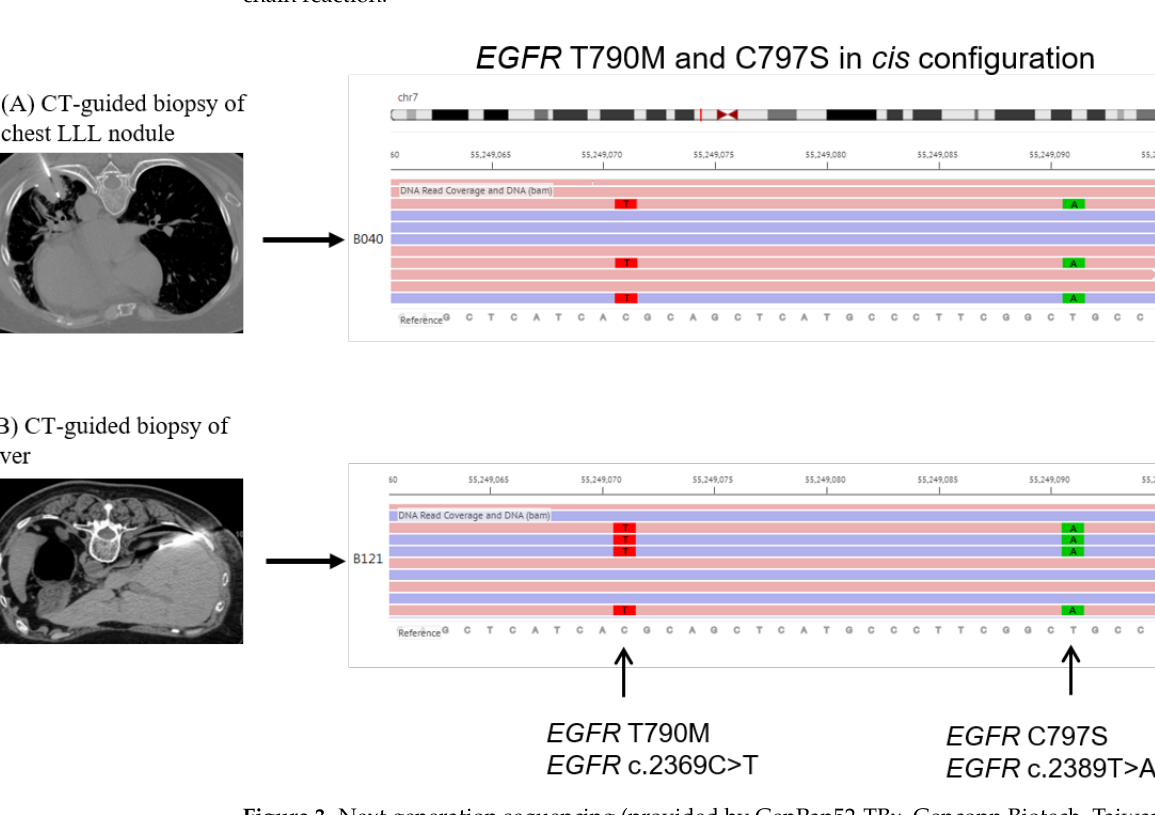
Figure 2. ( A ) Detection of EGFR exon 19 deletion in tumor tissues before treatment using Competitive Allele − Specific TaqMan ® PCR (ABI) in July, 2017. ( B ) Scorpions & ARMS (QI − AGEN) remained exon 19 deletion and new EGFR mutation T790M in tumor tissues at progression during afatinib treatment in October, 2018. ARMS − PCR, amplification refractory mutation system − polymerase chain reaction.